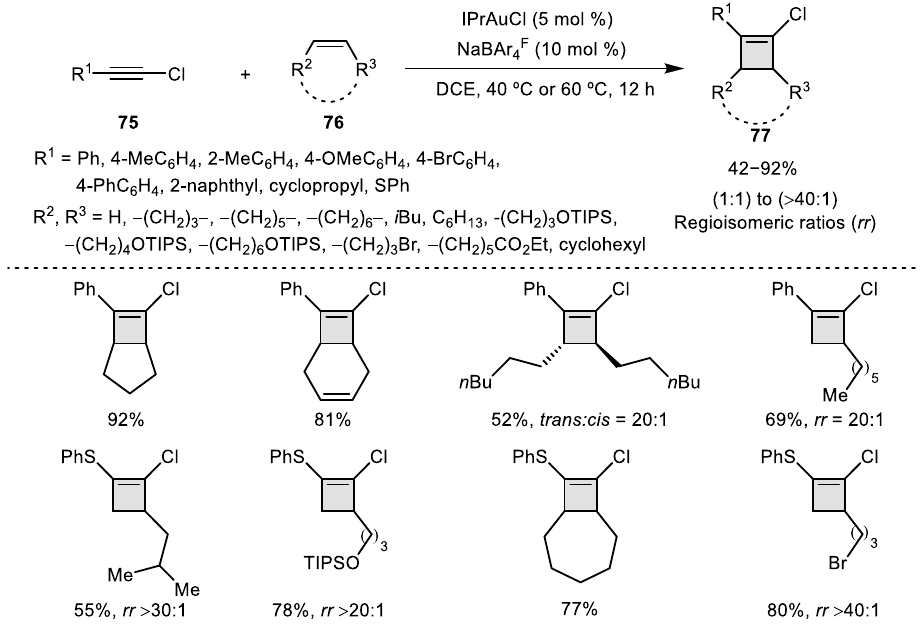
Figure 5. JoyaphosCl complexes. Recently, Echavarren´s group has reported other enantioselective synthesis of Rumphellaone A, in 12 steps (ca. 8% yield), and Hushinone a norsesquiterpenoid found in the essential oils from the buds of Betula pubescens , in 16 steps (ca. 1.1 % yield) [160]. The key step is a diastereoselective gold(I)- catalyzed [2+2] macrocyclization of 1,10-enyne 79 to build the cyclobutene moiety (Scheme 27). Scheme 27. Key step employed as an approach towards Rumphellaone A and Hushinone total syntheses. A convergent approach to the core bridged tricyclic BCD ring system of norditerpenoid alkaloids and Racemulsonine has been developed by Xu et al. through gold(I)-catalyzed [2+2] enyne cycloaddition and pinacol rearrangement (Scheme 28) [155].